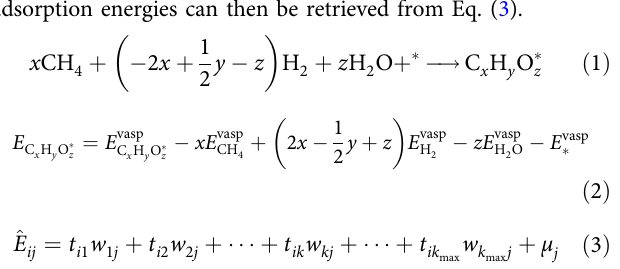
mentary Table 3. In the fi rst case, the MAE stagnates for two 98.1% of the variance is already captured. As a result, only two